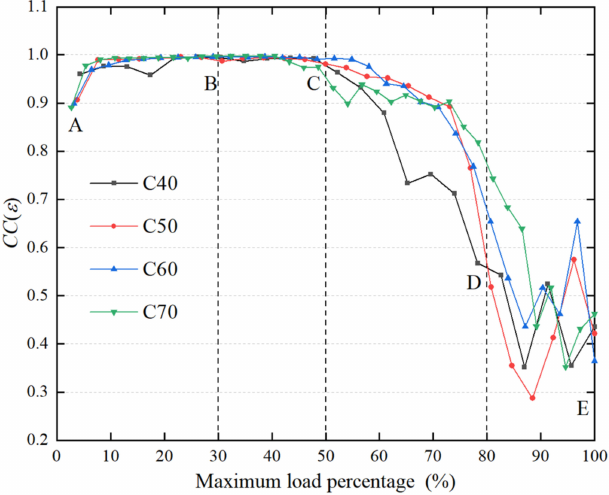
Figure 6. Correlation of the coda wave’s cross-correlation coefficient to the maximum load percentage.